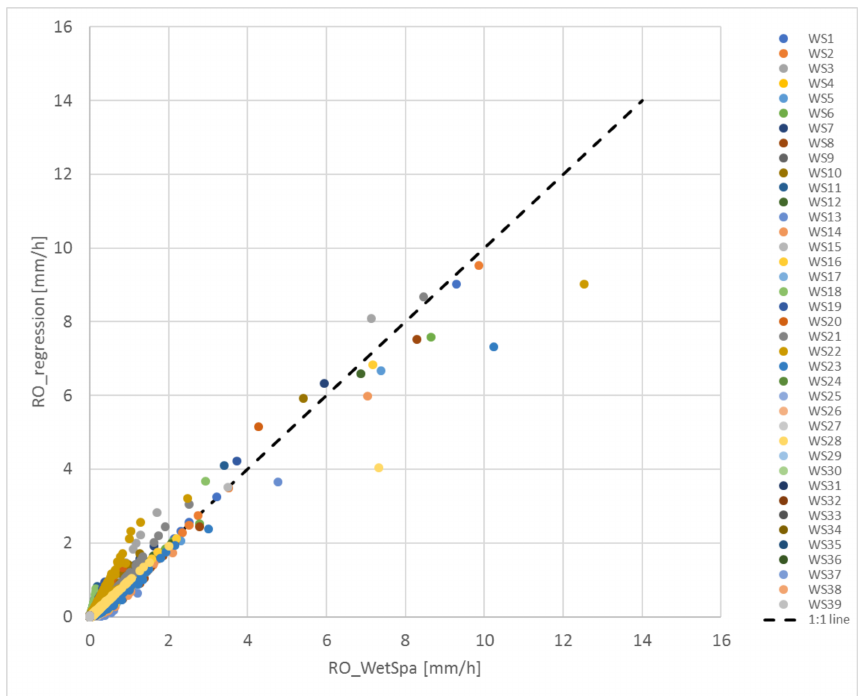
Figure 5. Surface runoff regression for the 39 sub-catchments (WS) of the